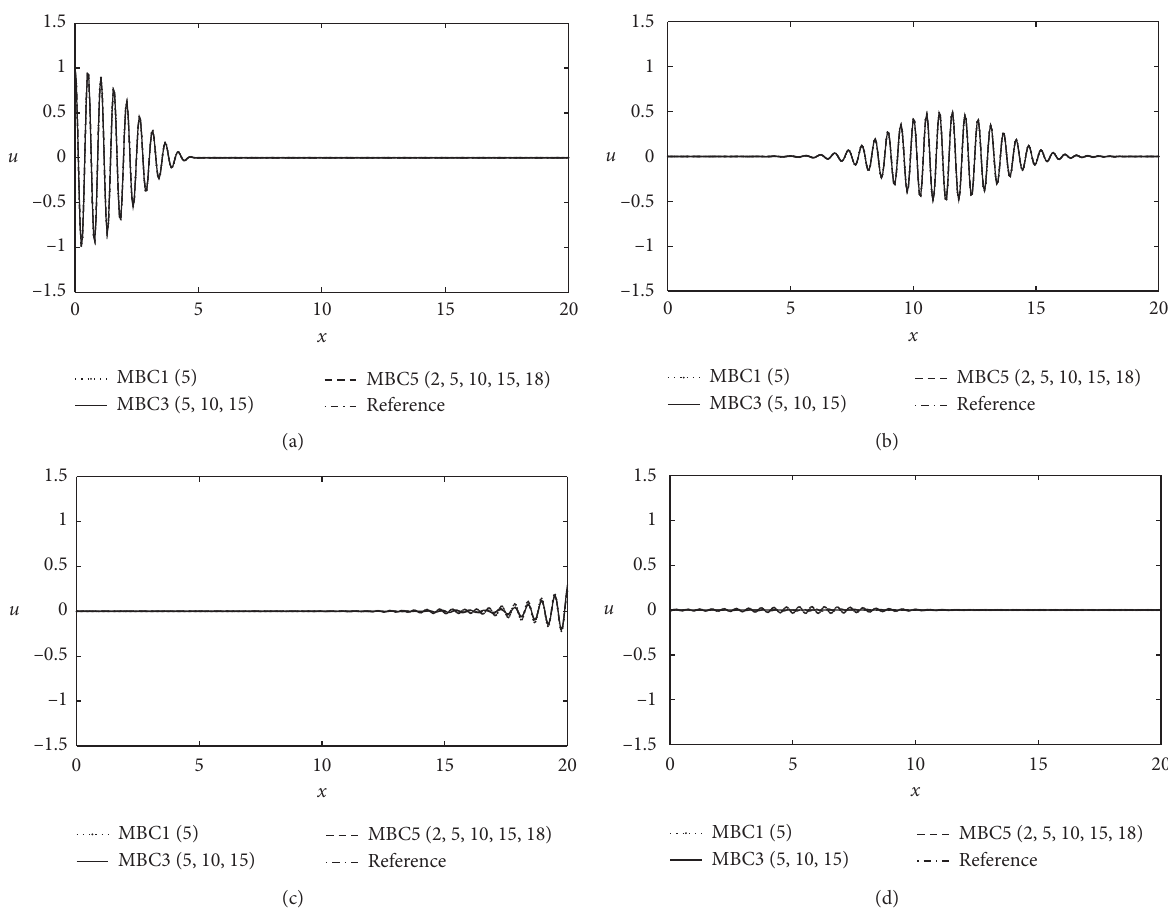
Figure 7: Time evolution of wave packet with the major wave number k � 12: (a) t � 0, (b) t � 0.5, (c) t � 1.0, and (d) t � 1.5.